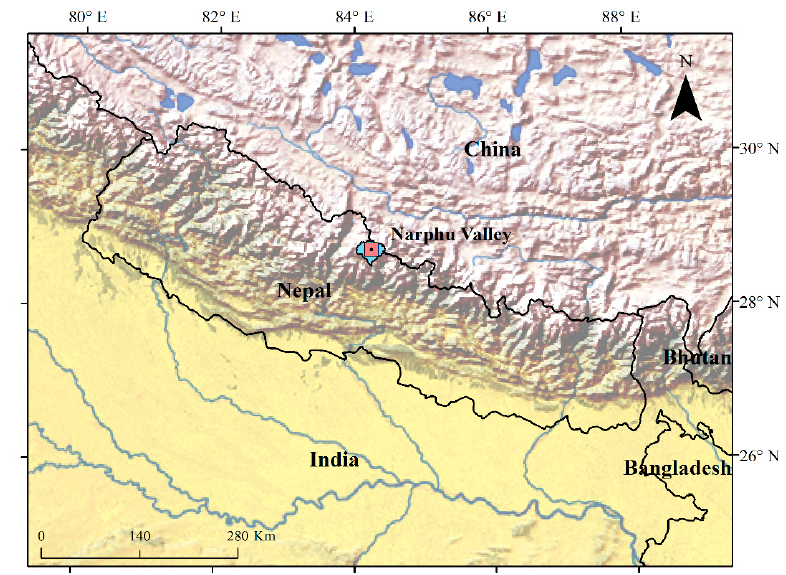
Figure 1. Map showing the location of study area, Narphu valley, Gandaki Province, Nepal.